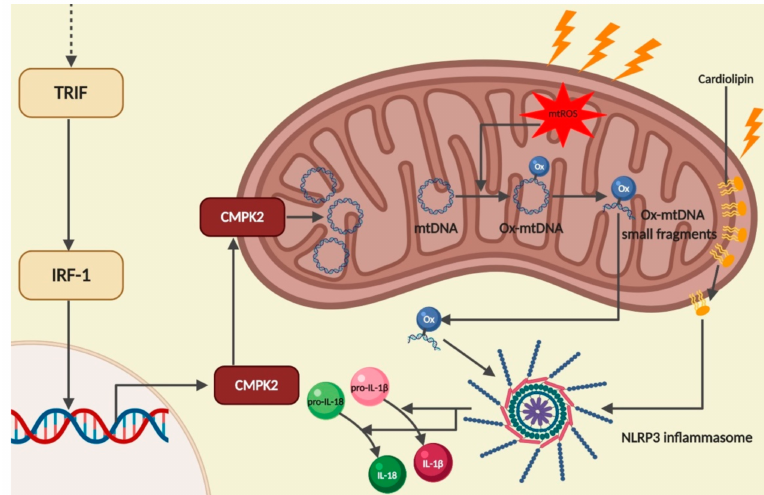
Figure 5. NLRP3 inflammasome activation via mitochondrial stress. After TLR4 recognition of a ligand, two main pathways are activated: the NF- κ B pathway in an early phase, via MyD88 (not shown), and the IRF1, via TRIF. IRF1 triggers the transcription of CMPK2, a rate-limiting enzyme that supplies deoxyribonucleotides for mtDNA synthesis. CMPK2 translocates to the mitochondria, where it